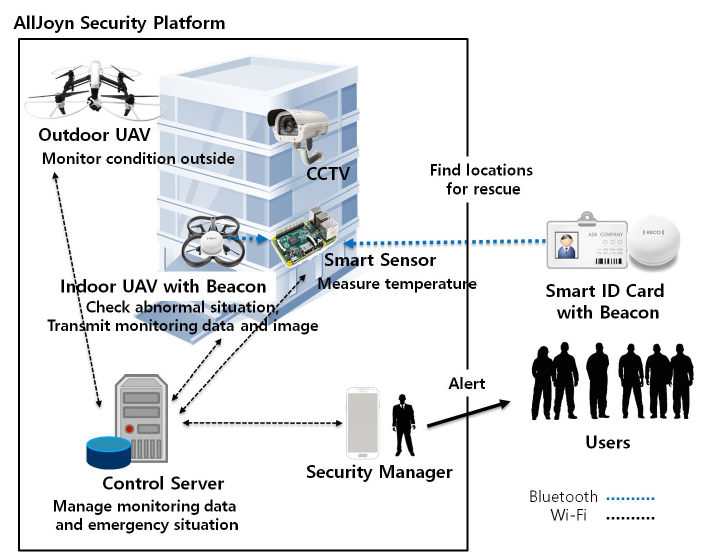
Figure 1. The overview of our UAV-assisted emergency monitoring and response system.